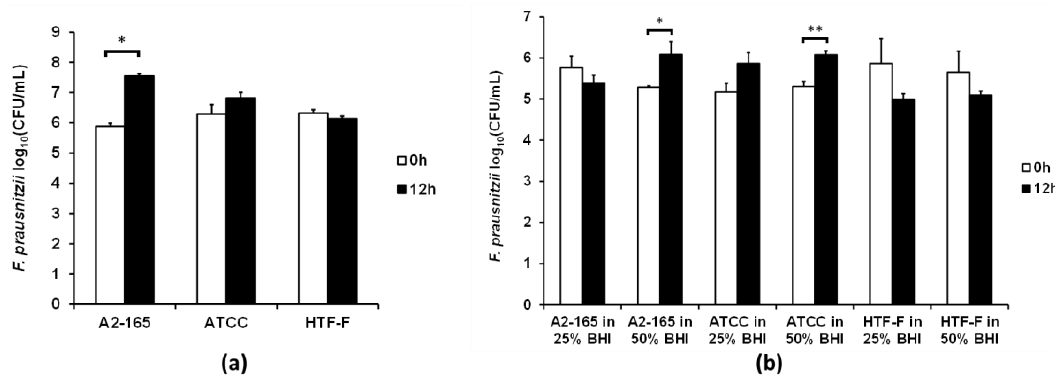
Figure 4. Viability of the three F. prausnitzii strains in a cell culture medium supplemented with bacterial culture medium. ( a ) In Hungate culture tubes. The three F. prausnitzii strains in stationary phase were resuspended in anaerobic M199 TEER: BHI (1:1) (referred to as 50% BHI) and incubated anaerobically at 37 °C. The graph shows the mean (±SEM; n = 3) log 10 (CFU/mL) of the three F. prausnitzii strains before and after 12 h of incubation in 50% BHI. * Mean log 10 (CFU/mL) differ between 0 and 12 h at p < 0.05. ( b ) In the apical anaerobic co-culture model with Caco-2 cells. The three F. prausnitzii strains were co-cultured with Caco-2 cells using two different media on the apical side of the Caco-2 cell monolayer (25% and 50% BHI). The graph shows the mean (±SEM; n = 4 and 8 for time 0 and 12 h, respectively) log 10 (CFU/mL) of the bacteria at 0 and 12 h of incubation with Caco-2 cells in the co-culture model. Mean log 10 (CFU/mL) differ between 0 and 12 h at * p < 0.05 and ** p < 0.01.